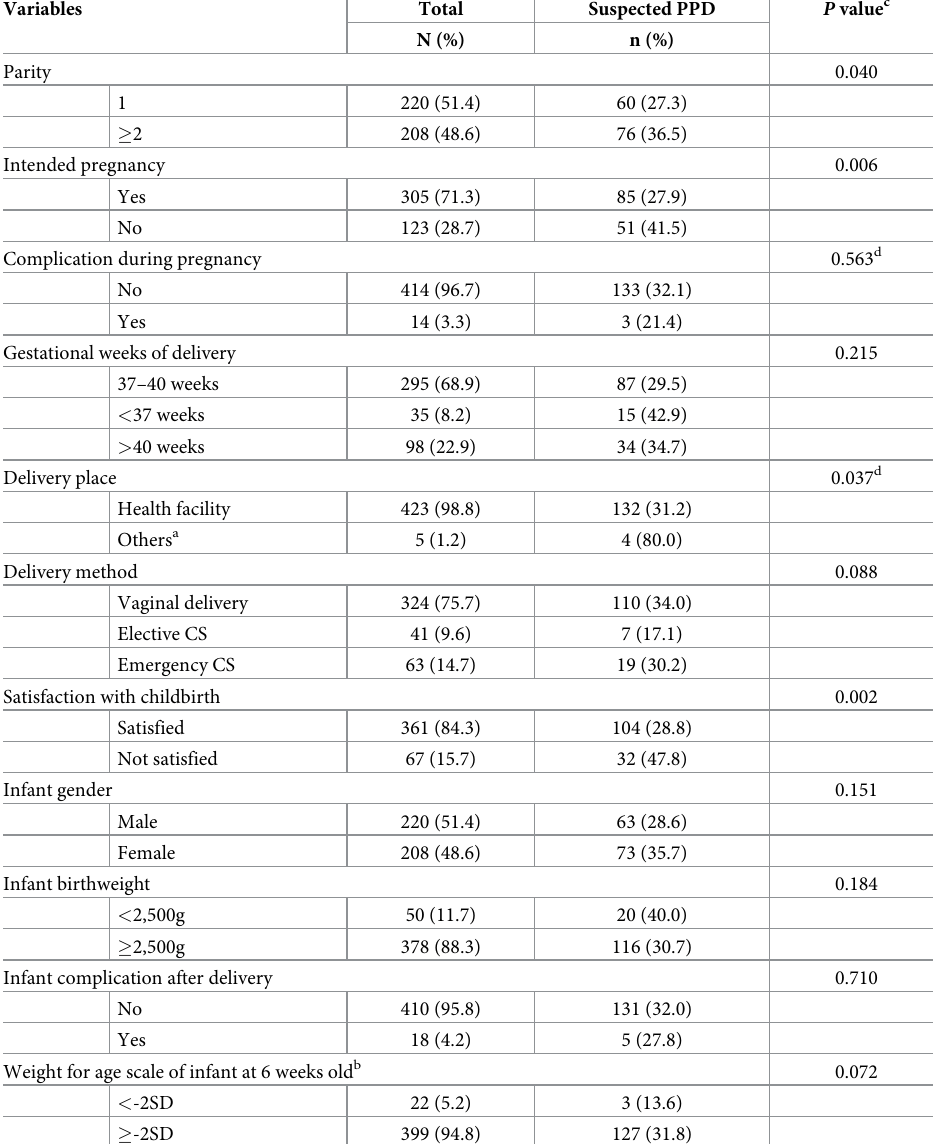
Table 2. Bivariate analysis of obstetrics and infant factors and suspected PPD among postpartum women. Variables Total Suspected PPD P value c